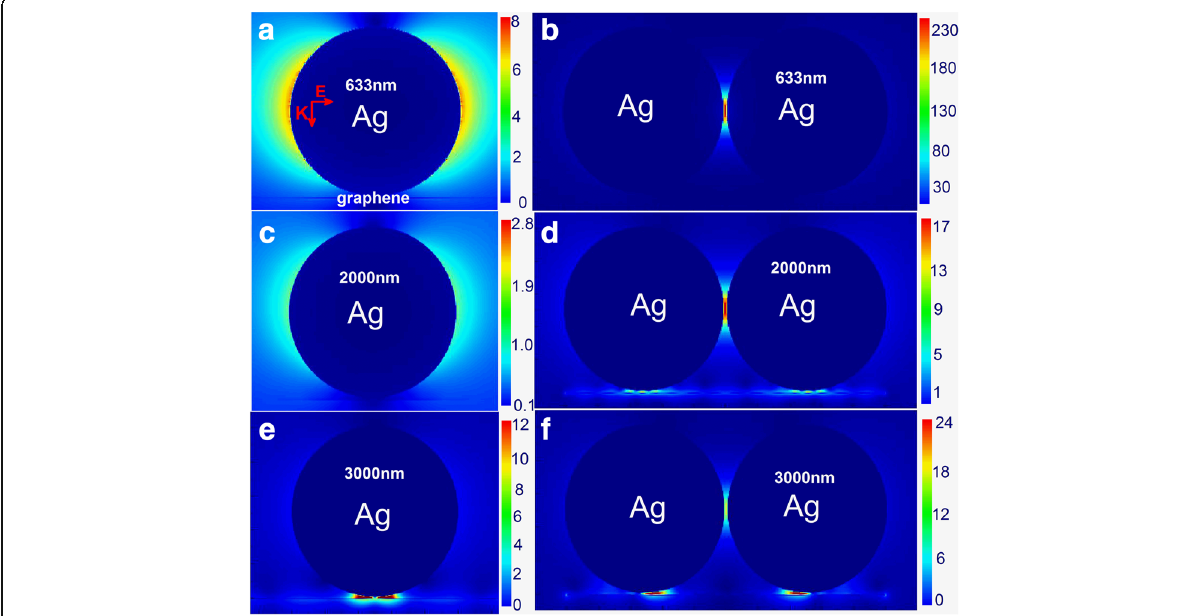
Fig. 1 Electric field redistribution in nanoparticle/graphene hybrid system. a , b Electric field distributions of R = 50 nm nanoparticle monomer and dimer on monolayer graphene film with a 1-nm gap at 633 nm, c , d at 2000 nm, and e , f at 3000